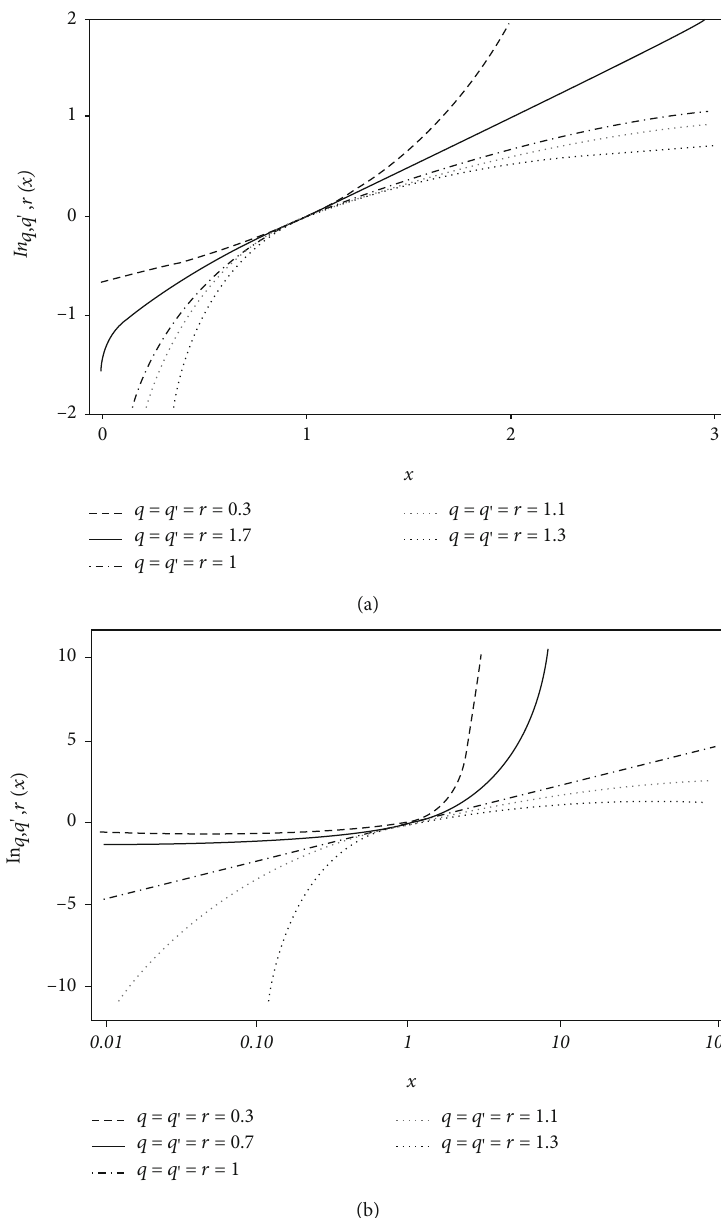
Figure 1: Illustration of the three-parameter logarithm in equation (32), setting q = q ′ = r in (a) linear scales and (b) semilogarithmic